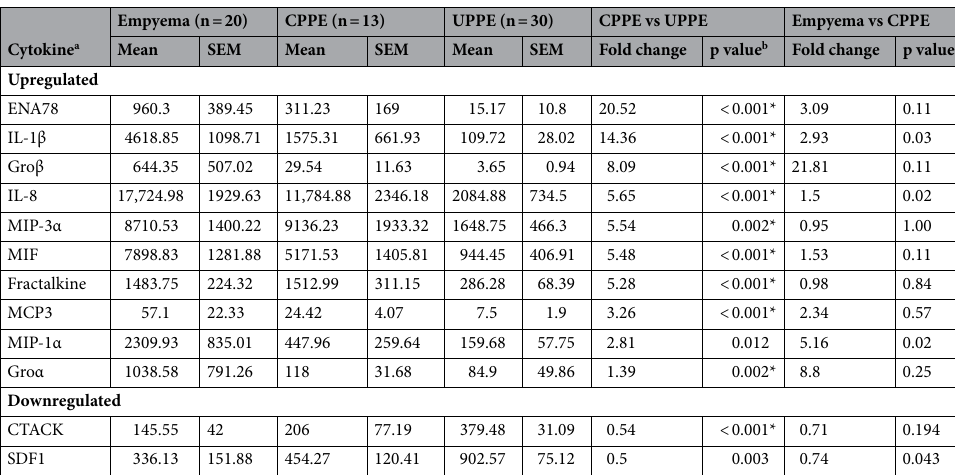
Table 2. Cytokine profiling in the discovery phase with the multiplex immunobead-based assay. a Data are presented as the fluorescence intensity measured in a multiplex immunobead-based assay. UPPE uncomplicated parapneumonic effusion, CPPE nonpurulent complicated parapneumonic effusion. Statistical analysis was done using Mann–Whitney U test for comparing the difference between b CPPE and UPPE or c Empyema and CPPE. Bonferroni-adjusted p-values < 0.05/24 (12 cytokines and 2 comparisons) = 0.0021 indicate